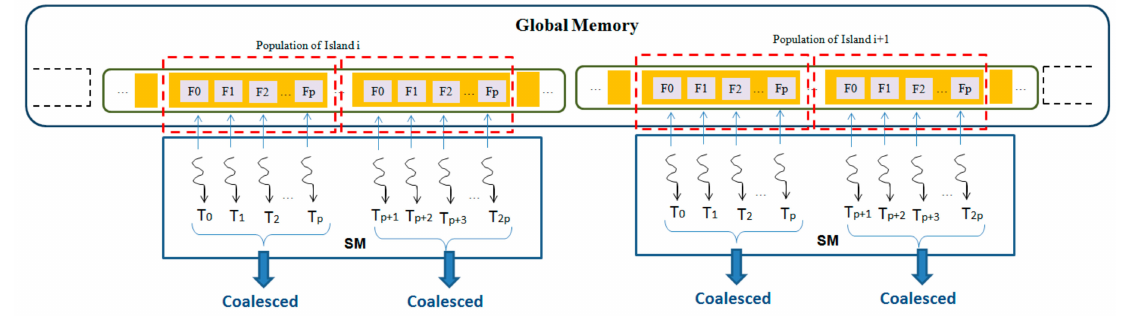
Figure 14. Memory coalescing represents a data